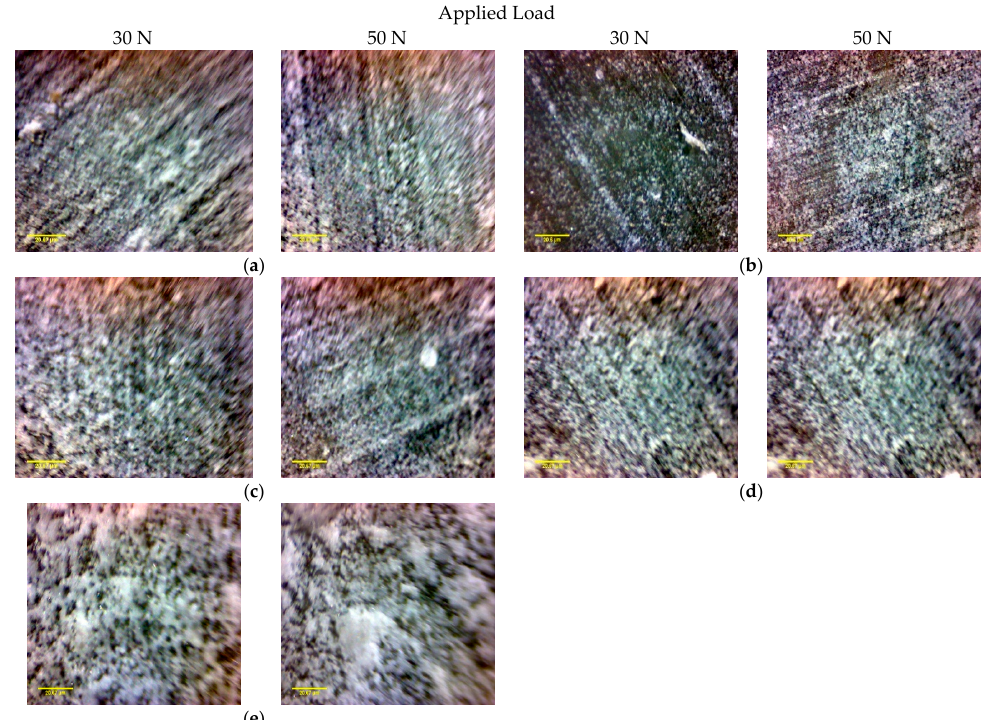
Figure 13. The optical micrographs of the worn surfaces of investigated samples under various normal loads at a sliding velocity of 0.79 m/s for ( a ) the neat epoxy, M 1 , ( b ) M 2 , ( c ) M 3 , ( d ) M 4 , and ( e ) M 5 .